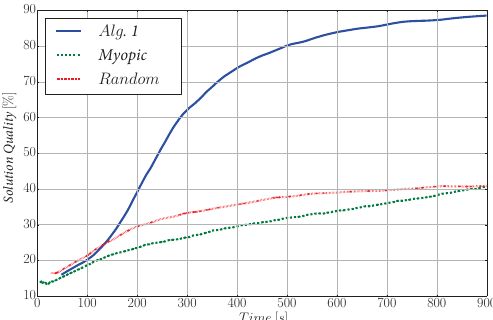
Figure 7. Quality of the solution achieved by Algorithm 1, a myopic, and a random trajectories after a 900 s mission. A 100% corresponds to the best possible solution. These curves correspond to the mean value achieved over the simulations carried out for scenarios A and B.